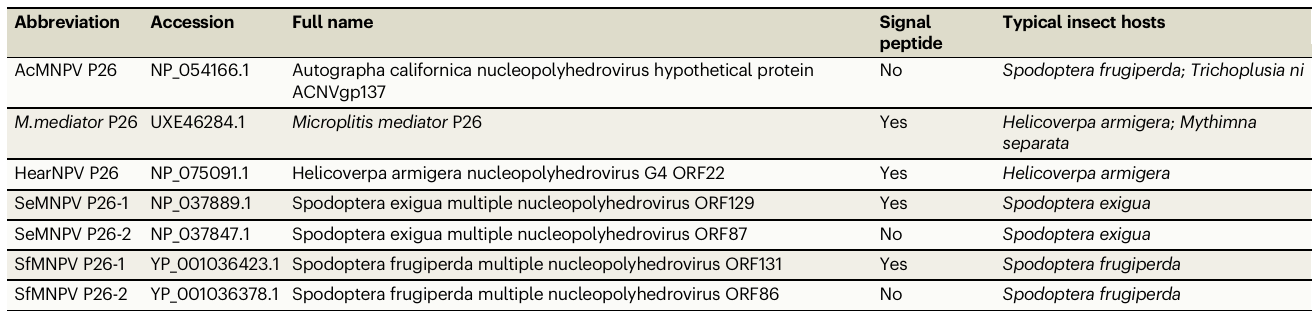
Table 1 | Information of baculovirus and wasp P26